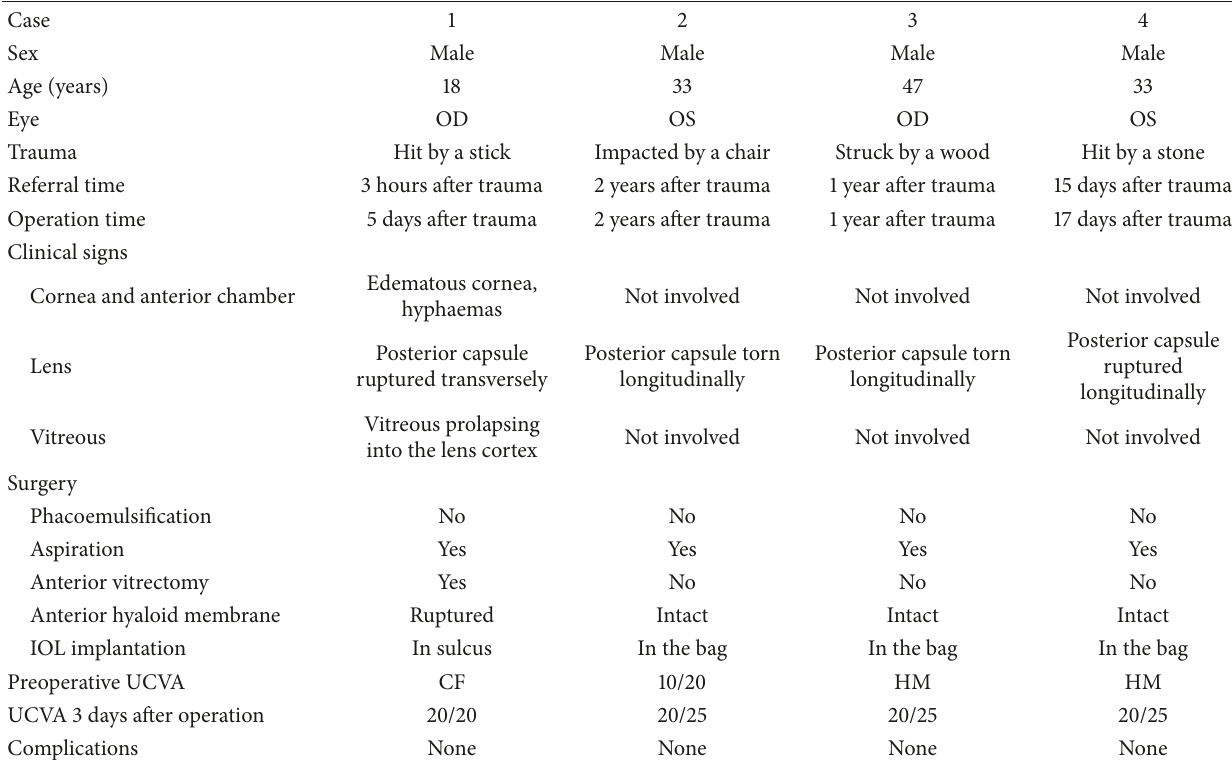
Table 1: Characteristics of four cases of traumatic cataract with posterior capsular rupture